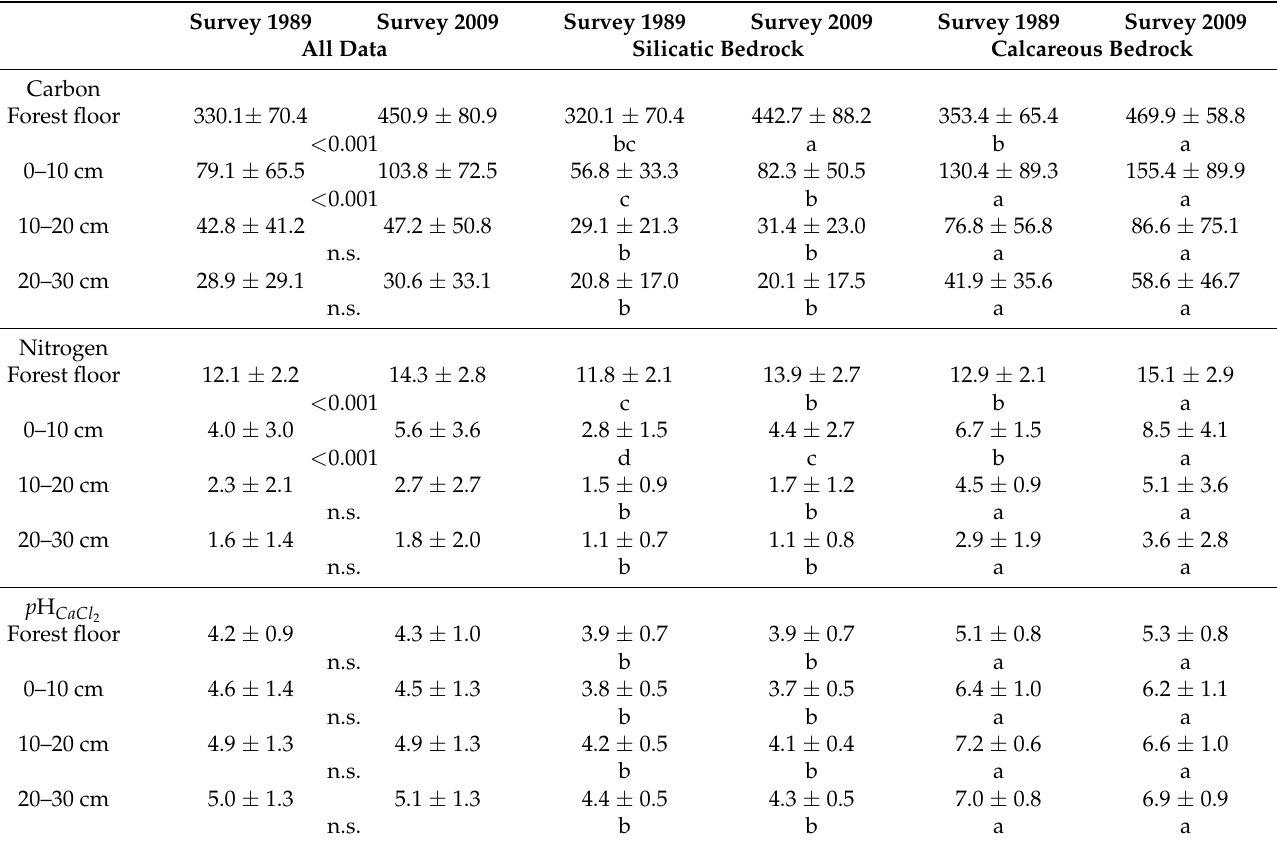
Table 1. Comparison of concentrations of carbon and nitrogen (mgg − 1 ) and the pH value in a repeated soil survey. The values are the arithmetic mean ( x ) and the standard deviation ( sd ) of a sample size of n = 119 sites, with 90 sites on silicatic and 29 sites on calcareous bedrock. Statistical differences between the two soil surveys are given by the p -values; differences between the strata ‘survey’ and ‘bedrock’ are shown by letters that indicate the grouping according to a comparison of means (Tukey